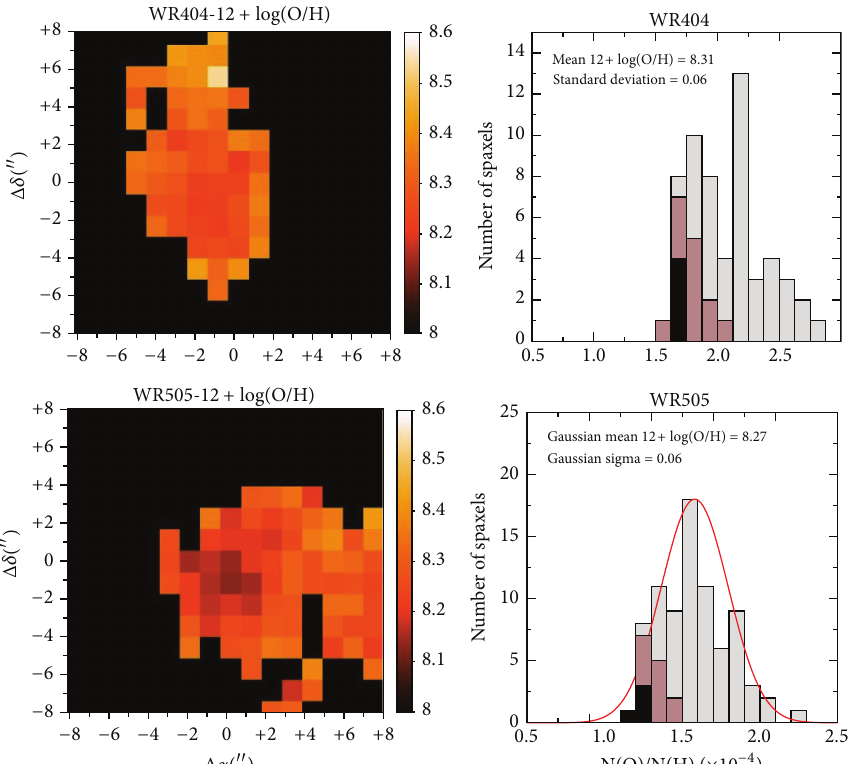
Figure 3: Oxygen abundance maps derived as described in the text and histogram distributions in linear scale for WR038, WR039, and WR057. In all images, each spaxel has 1 󸀠󸀠 resolution, north is up and east is left. The bars in the histogram represent spaxels with detected WR emission (red), spaxels in the same positions as the SDSS pointing (black), spaxels adjacent to this position (brown), and the other spaxels (grey). Same figure for WR266, WR404, and